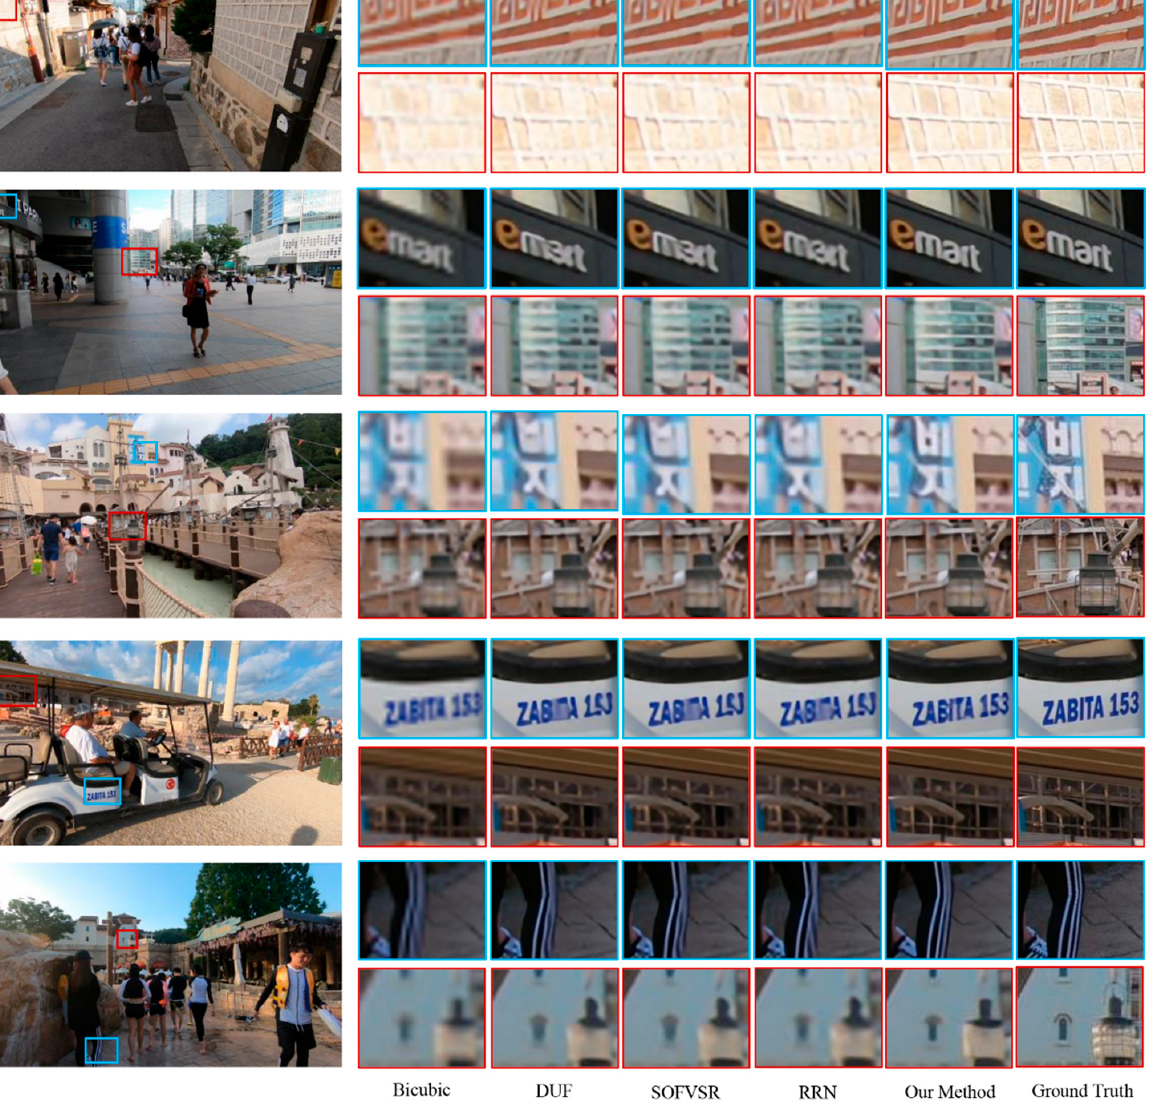
Figure 5. Visual comparison of the results on the REDS dataset. The images on the left are the results of our method. The zoomed images on the right side are the results of various methods for the area in the bounding box(The Korean in the third figure means ‘busy’).